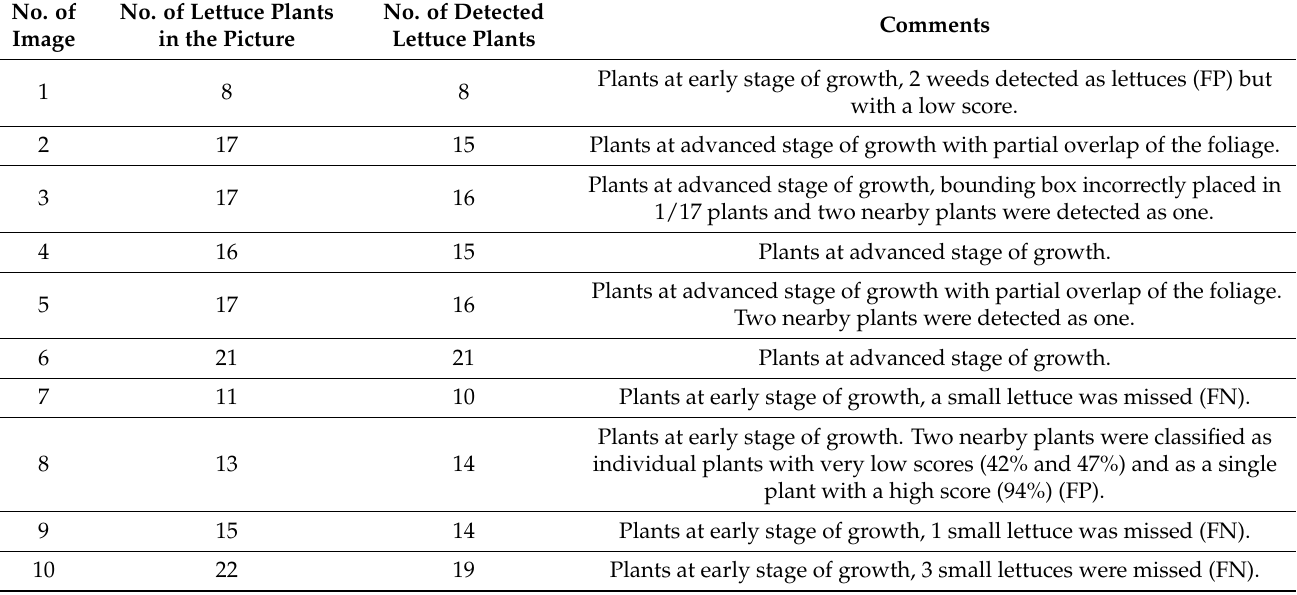
Table 1. Plant detection test results.